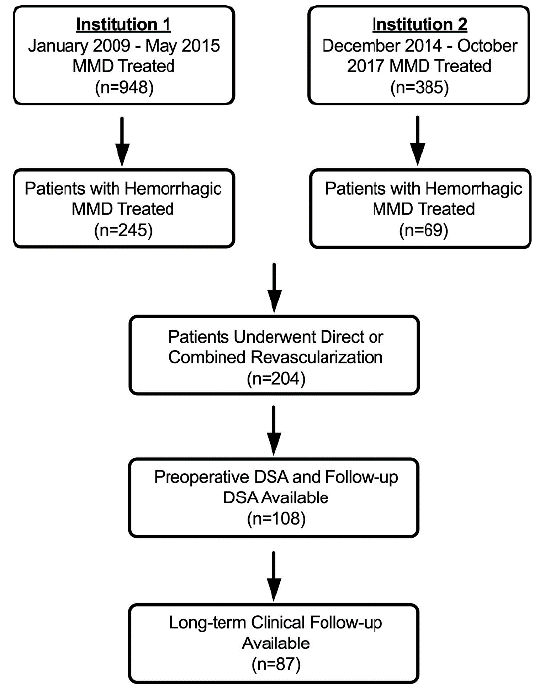
Figure 1. The flow diagram of patient screening. Table 1. Baseline characteristics of patients with and without delayed anastomotic occlusion.